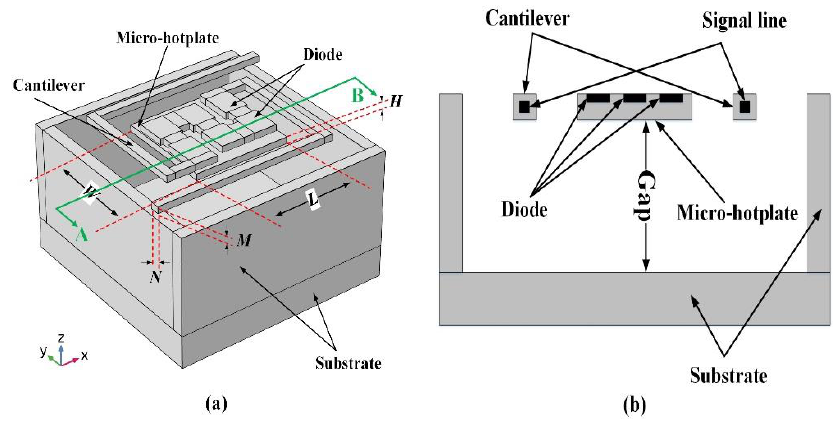
Figure 5. ( a ) Schematic and ( b ) cross-sectional views of the redesigned micro-Pirani vacuum sensor structure.